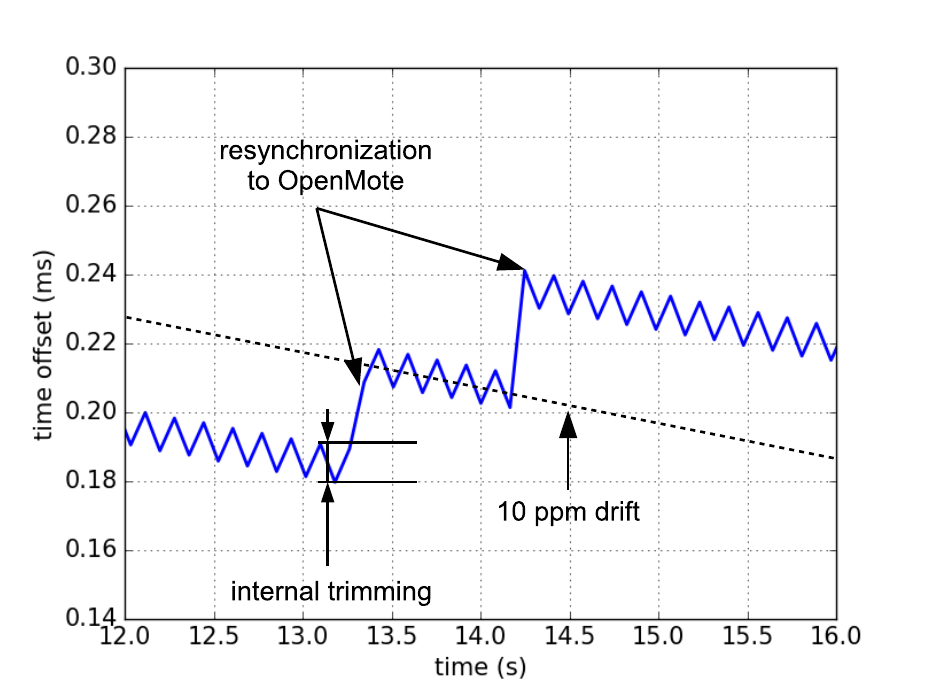
Figure 9. Time offset between SCµM and OpenMote when SCµM periodically re-synchronizes to OpenMote. SCµM uses a digital trimming (tick skipping) algorithm to compensate for the drift shown in Figure 8. The result is that SCµM stays synchronized to OpenMote within 300 µ s of synchronization